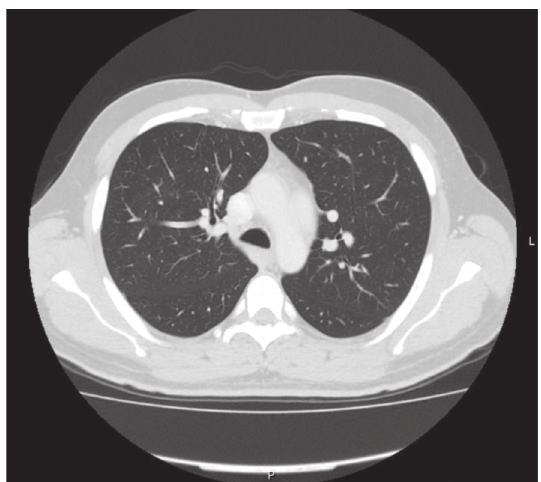
Figure 3: Follow-up chest CT showing resolution of the ground glass areas and the bilateral pleural Table 2: Published clinical cases of CMV pneumonia in immunocompetent individuals.